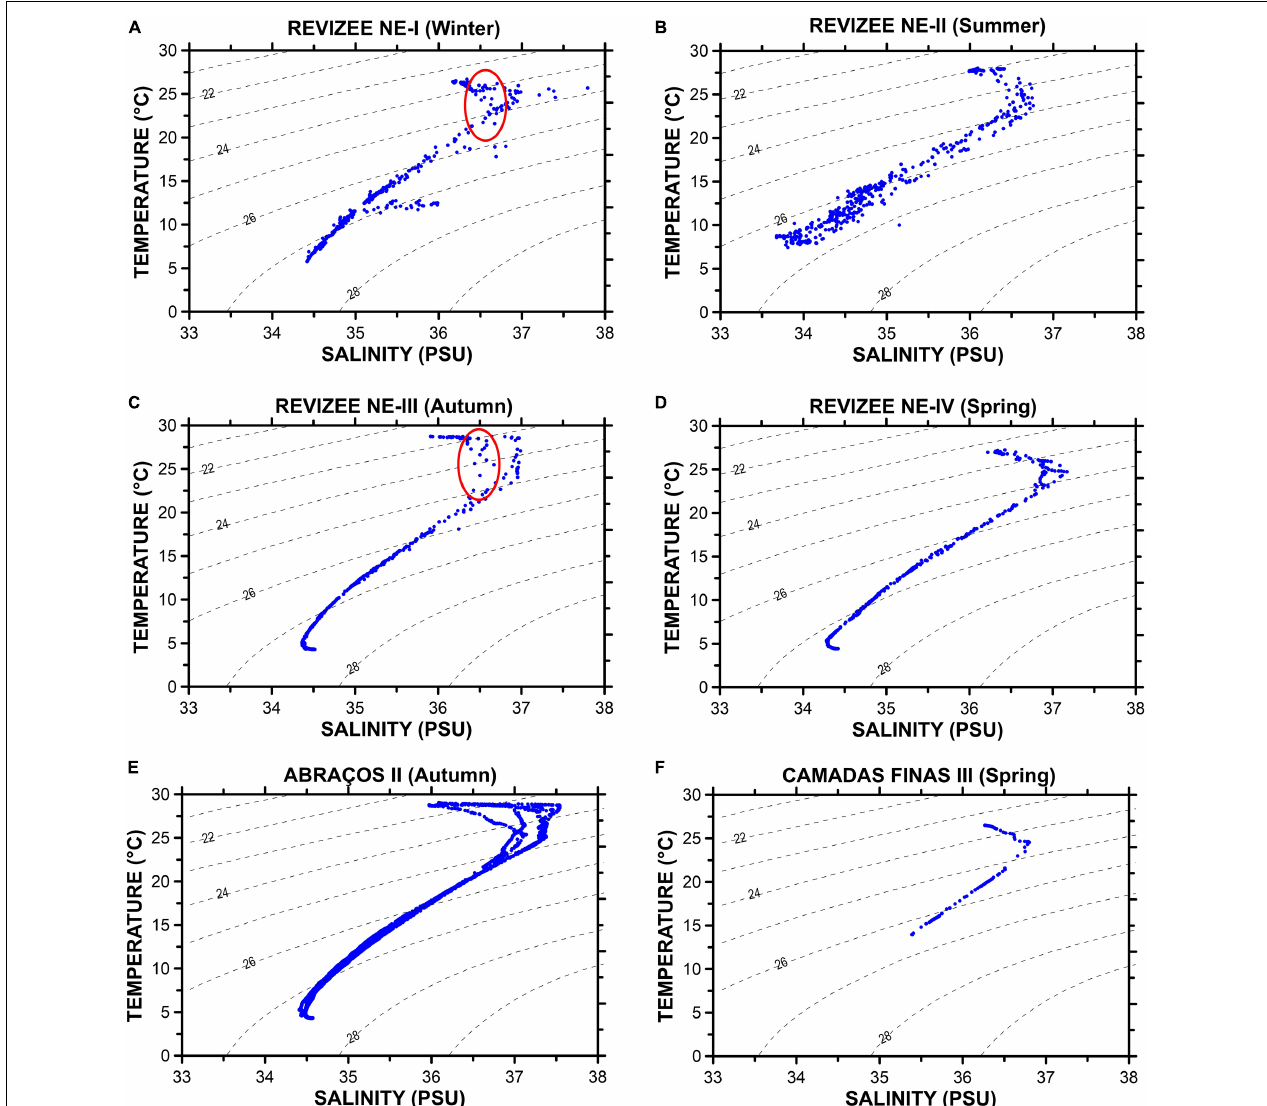
FIGURE 3 | Seasonal variability in T/S diagrams in the Aracati Bank area during cruises (A) REVIZEE NE-I, winter; (B) REVIZEE NE-II, summer; (C) REVIZEENE-III, autumn; (D) REVIZEE NE-IV, spring; (E) ABRAÇOS II, autumn; and (F) CAMADAS FINAS III, spring. Blue dots are T and S field CTD data for upstream region of the Aracati Bank (Geber, 2001). The red ellipses indicate the dispersion of the termodynamical characteristics of the waters near the interface between the Tropical Water and the South Atlantic Central Water masses